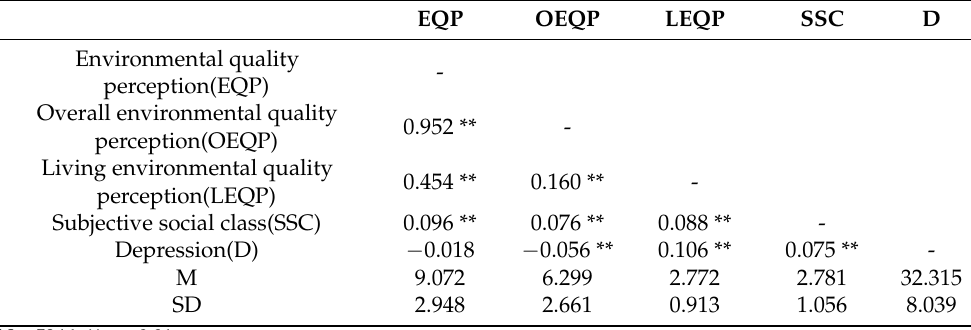
Table 2. Descriptive statistics and correlation coefficients for the study variables.